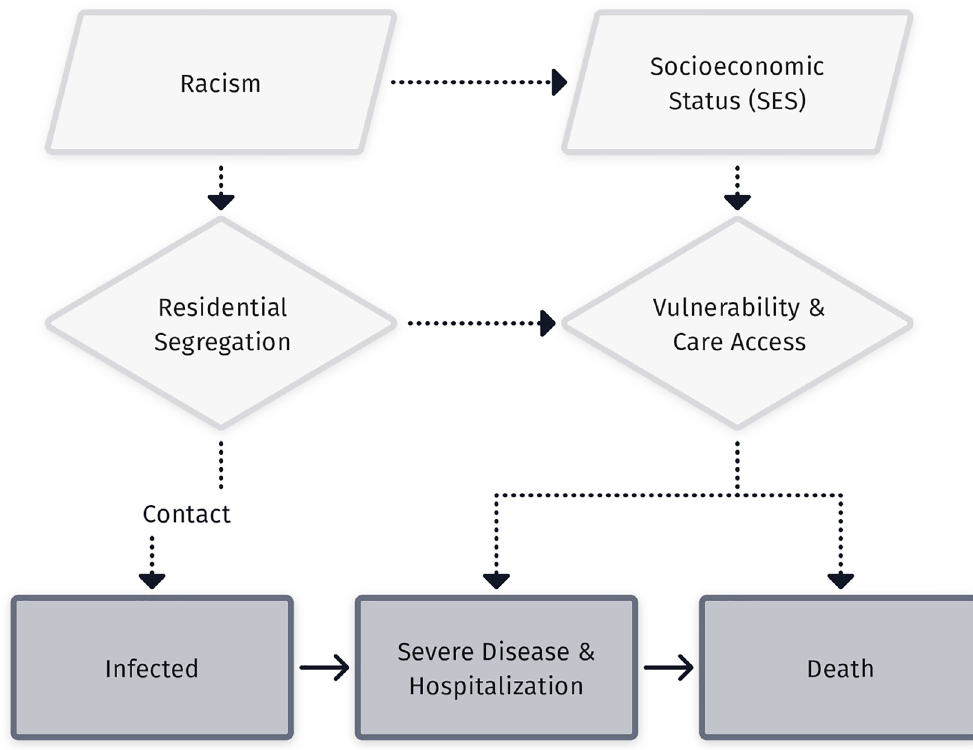
Fig 1. Illustration of the impact of fundamental causes on inequity in infection through multiple intervening mechanisms and multiple outcomes. The figure illustrates key relationships between high-level fundamental causes of social inequality (parallelograms) on risks of infection and disease progression (rectangles) via their impact on more-proximal risks for exposure, severe disease upon infection and death (diamonds). Solid lines represent flows between disease states, while dotted lines illustrate relationships between risk factors and their impacts on susceptibility to infection acquisition and the rate of progression through escalating phases of disease severity. For visual clarity, only a subset of potential relationships is illustrated. For example, racism impacts vulnerability and access to care directly as well as indirectly, and SES and wealth often contributes to residential segregation. SES, socioeconomic status.